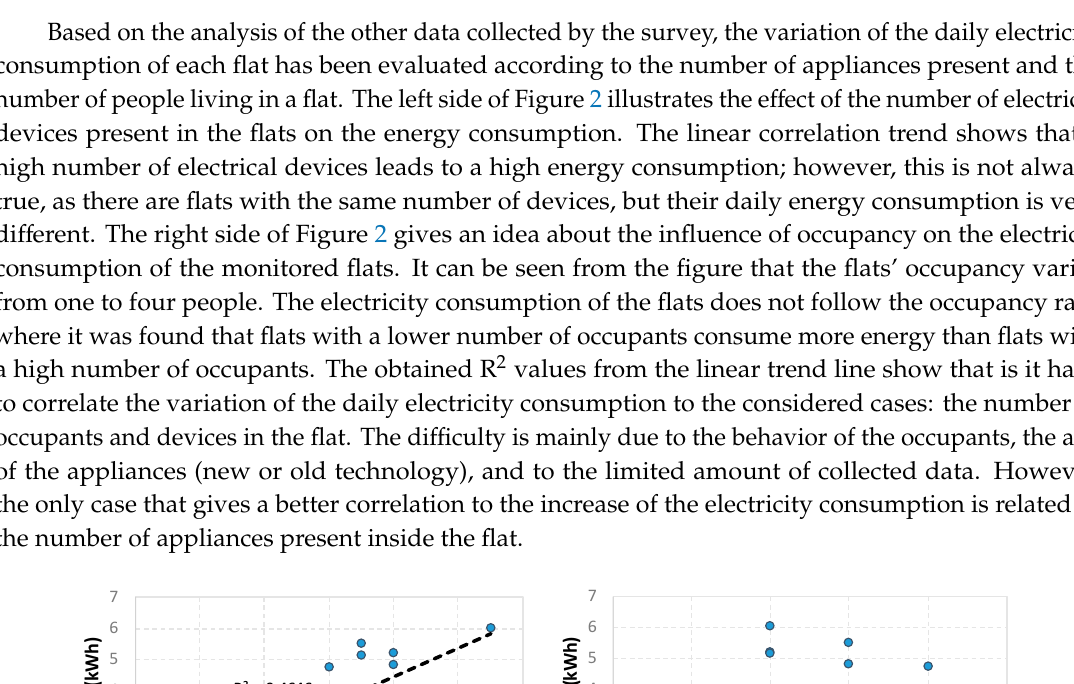
Figure 1. Percentage of flats having the following list of appliances.